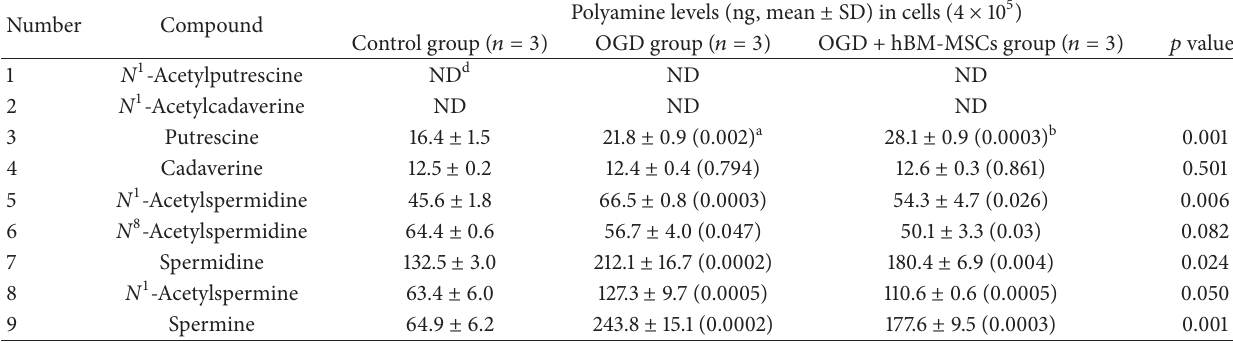
Table 2: Polyamine levels in cells from control, OGD, and OGD + hBM-MSCs groups for 72 h.